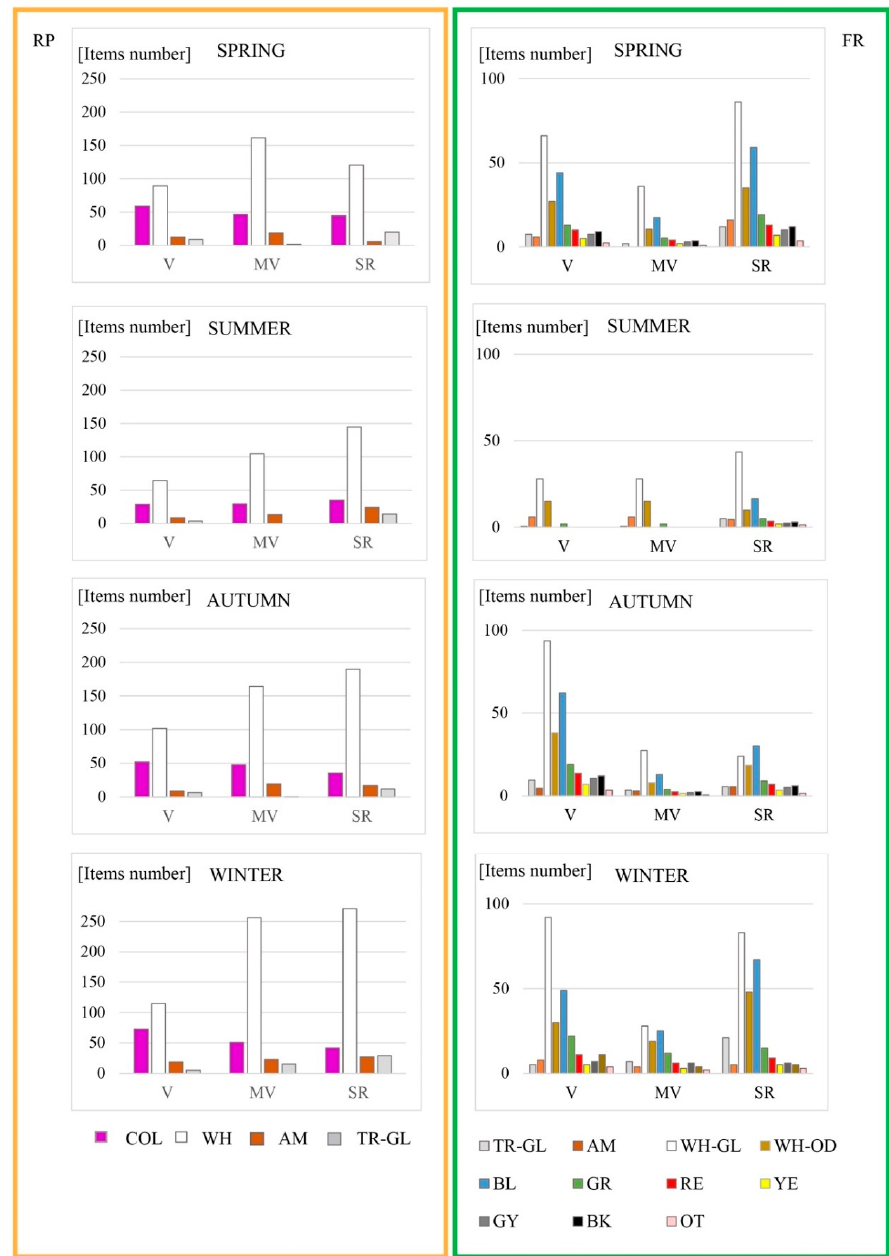
Figure 7. Seasonal color distribution of RP and FR collected from each beach. Error bars have not been plotted in the graph for a better visualization of the data, but they are reported, with data, in Tables S5 and S6 in Supplementary